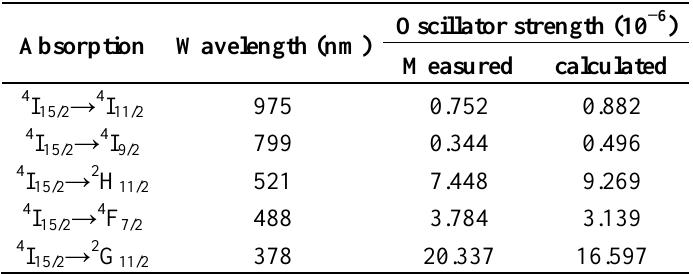
Table 1. Measured and calculated oscillator strength of Er 3+ in TF